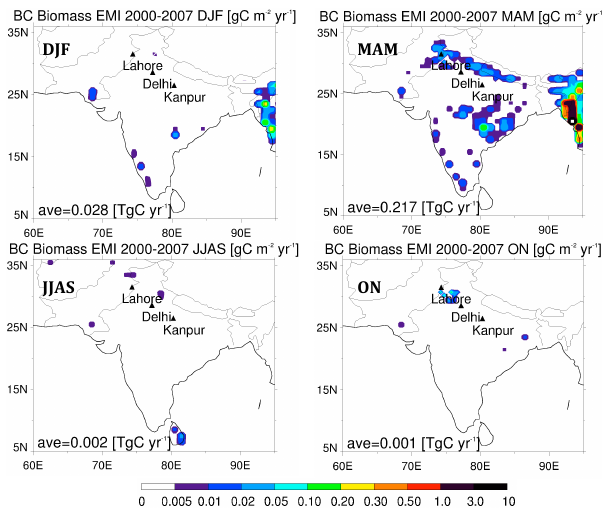
Figure 3. Spatial distribution of biomass burning emission of BC based on GFED2 for each season averaged for 2000–2007 (units: gCm − 2 yr − 1 ) over South Asia (60–95 ◦ E, 5–36 ◦ N). The seasonal mean emission amount over South Asia (land only) is shown at the bottom. Note that the color scale is the same as that of BC in the Fig. 2 for the purpose of